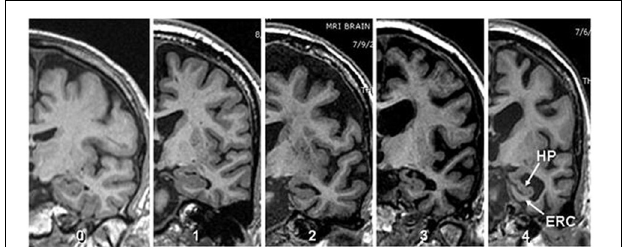
FIGURE 1 | Visual rating scale. Image depicting four degrees of atrophy in Hippocampus and Entorhinal cortex according to visual rating scale where 0 = no atrophy, 1 = minimal atrophy, 2 = mild atrophy, 3 = moderate atrophy and 4 = server atrophy (Score shown corresponds to both